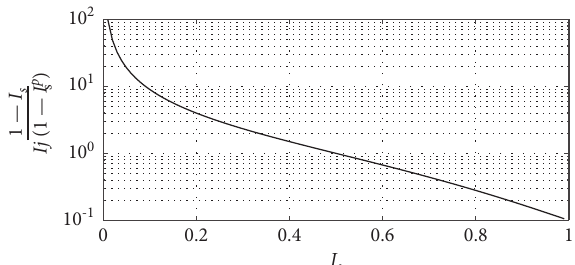
) / [ I ( 1 − I p s )] with respect to I s s